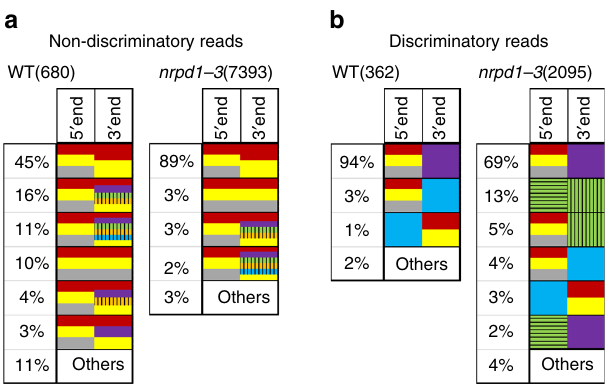
Fig. 4 DNA sequencing of pair-end reads starting at the ends of LTRs of Onsen reveals recombinant LTRs in ecDNA of heat-stressed wild-type and nrpd1-3 plants. a Non-discriminatory pair-end reads (see text). b Discriminatory pair-end reads reveal the occurrence of recombinant LTRs. Colour code as in Fig. 1a. Horizontal or vertical bars are present only in those cases where NGS reads matching old Onsen members contained polymorphisms that allowed discrimination of 5 ′ and 3 ′